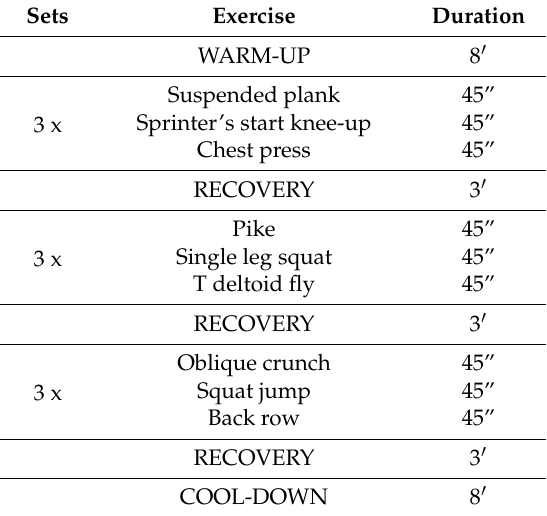
Table 1. Schematic Representation of the 50 min Suspension Training Group Session. Sets